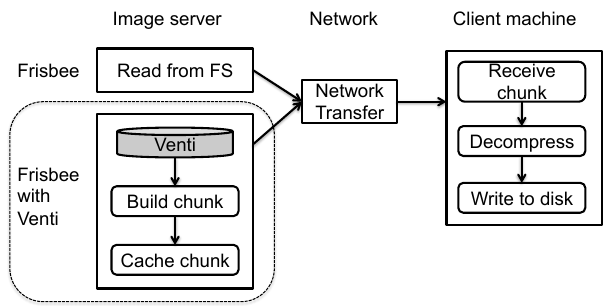
Figure 2: Frisbee’s two-level pipelining design and the design of VF. In the new design of VF, the first stage (Read from FS) is replaced with chunk construction from